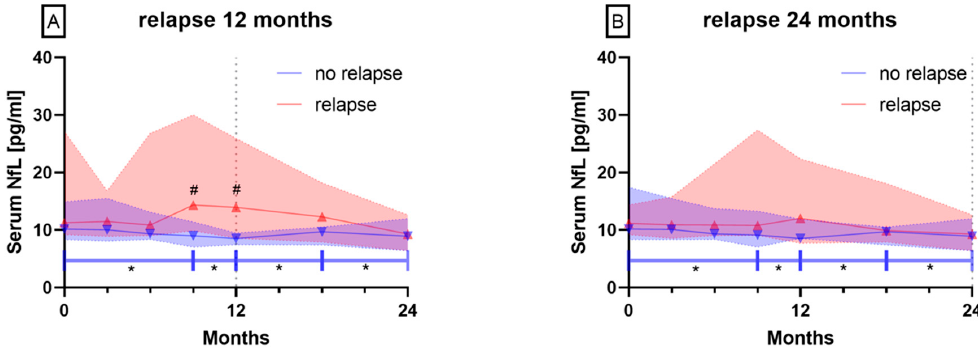
Figure 2. Serum NfL levels over 12 and 24 months in patients with (red triangle facing up) and without relapse (blue triangle facing down) for ( A ) 12 or ( B ) 24 months. Symbols show median values, colored range indicates 95% confidence interval (CI), * p < 0.05 for intragroup differences, # p < 0.05 for intergroup differences.